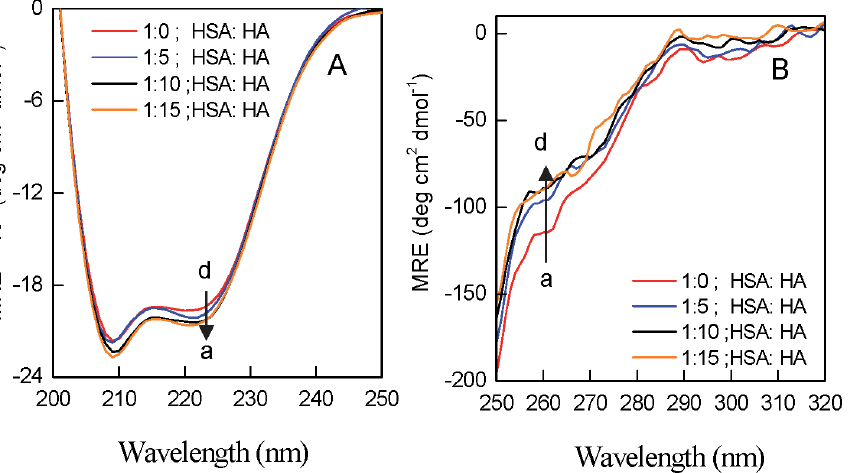
Figure 4. Far (A) and near (B) UV CD spectra of HSA in the presence of varying concentration of HA. a-d represent spectra of HSA: HA at molar ratio of 1:0, 1:5, 1:10 and 1:15 respectively in both (A) and